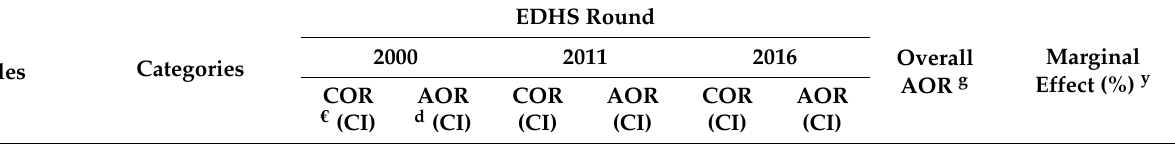
Table 4. Factors associated with an MMF, EDHS 2000 to 2016 (cid:51)